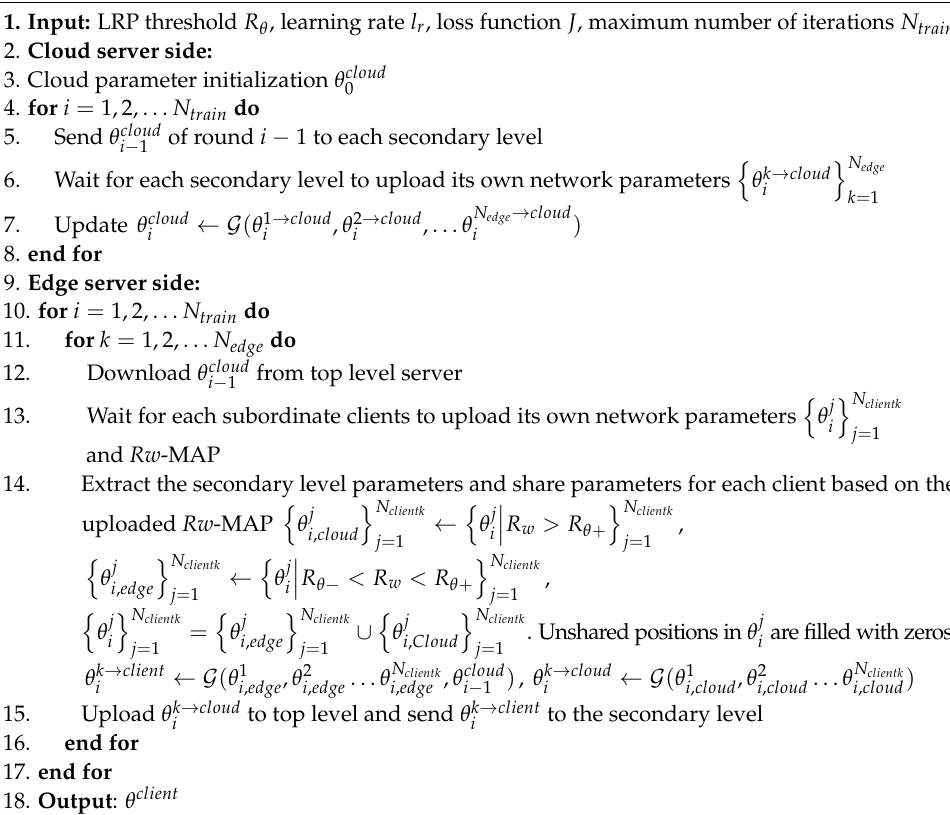
Algorithm 1: i -MFN algorithm for server